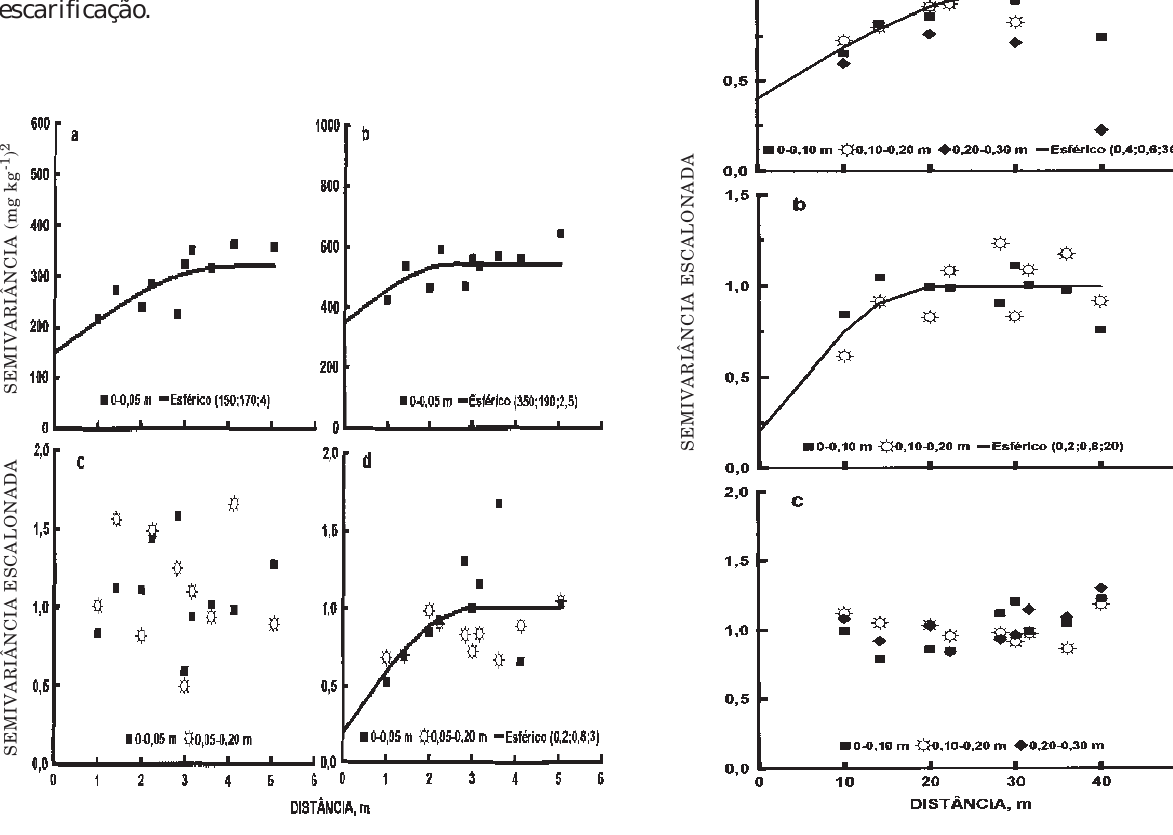
Figura 2. Semivariogramas para fósforo no solo nas áreas amostradas em Passo Fundo (RS), para (a) preparo convencional, (b) plantio direto e (c) pastagem. As legendas dos gráficos incluem o modelo ajustado aos dados e, entre parênteses, os coeficientes C 0 , C 1 e alcance da dependência espacial; C 0 + C 1 representam o patamar do